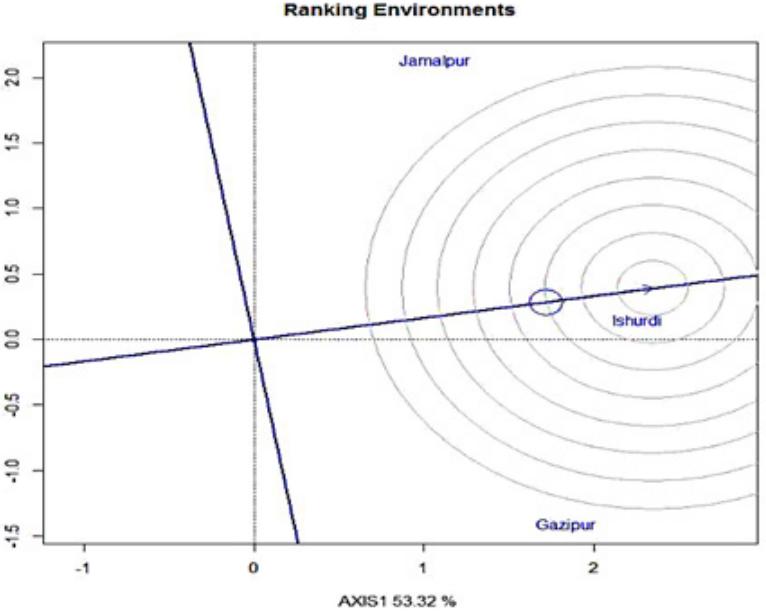
Figure 6: The discrimination and representativeness view of the GGE biplot to rank test environments relative to an ideal test environment (represented by center of the concentric circles) “which wins where” structure. The polygon is formed by Figure 2, the vertex genotypes of the polygon are the most connecting the furthest genotypes from the biplot origin favorable genotypes for a particular environment (Ding et after then lines are drawn perpendicular to the sides al. 2007; Yan 2002; Hossain et al. 2018). In this Biplot, five of the polygon so they pass through the origin. These perpendicular lines divide the biplot into five sectors and perpendicular lines divide the biplot into some sectors. the locations fell into two of them. Location Jamalpur fell According to the polygon view of GGE biplot shown into sector 1 with the most favorable genotype ‘E2’ whereas